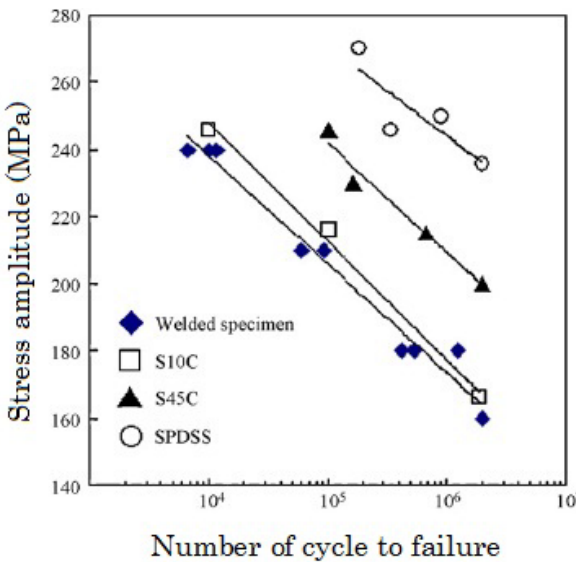
Figure 3. The numbers of cycles to failure at various stress amplitudes for the S45C-SPDSS specimen bonded by SPF-DB, S45C, SPDSS and S10C